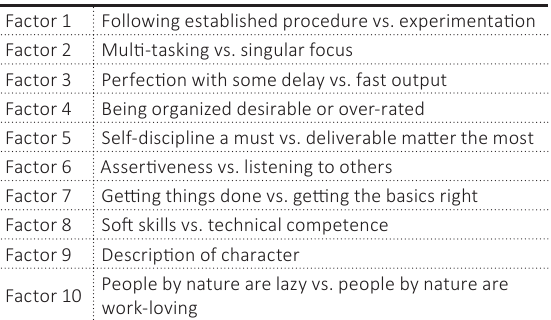
Table 1. Workplace Characteristics Factors